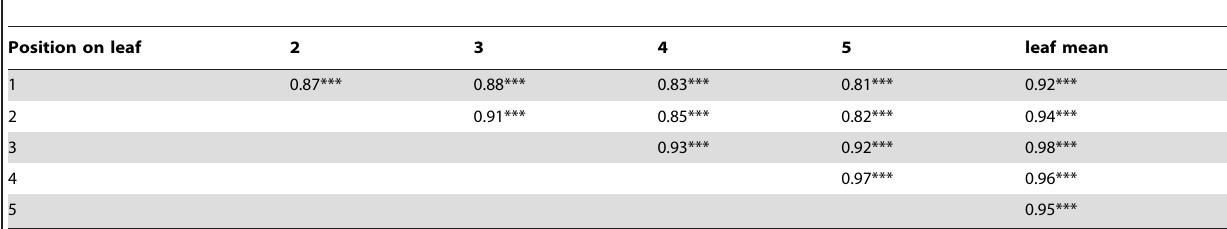
Table 2. Correlations of date 5 YEFL (Young Fully Expanded Leaf) SPAD readings of chlorophyll content per unit area between 5 measurement positions and leaf mean in Experiment